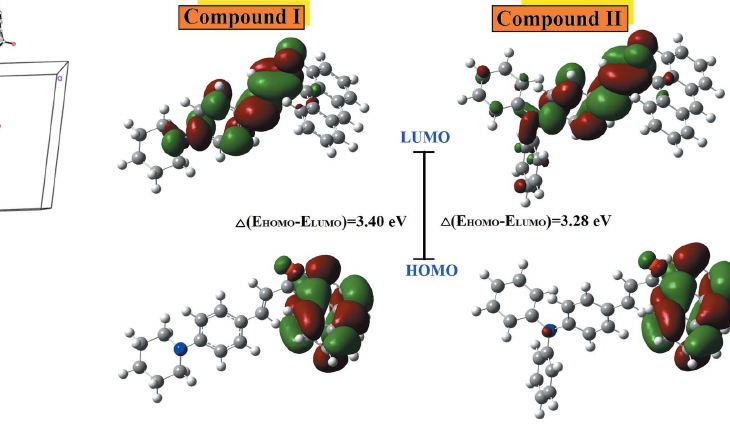
Figure 5 The electron distribution of the HOMO and LUMO energy levels of (I) and